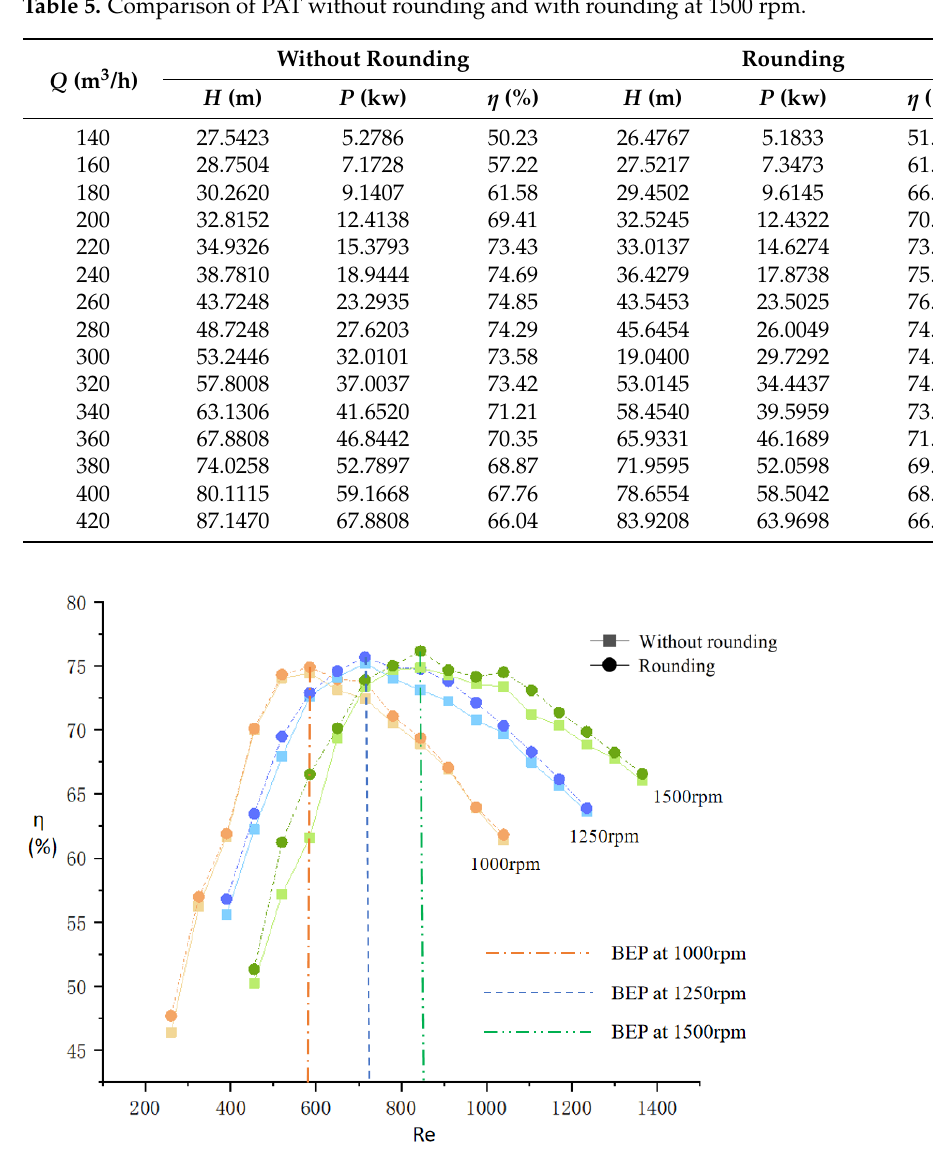
( b ) Figure 9. Pressure contours of flow region at 1000 rpm. ( a ) Original model; ( b ) rounded model.